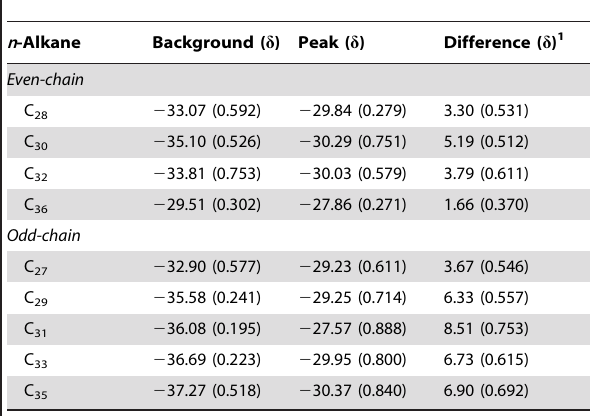
Table 2. Mean background and peak concentrations of d 13